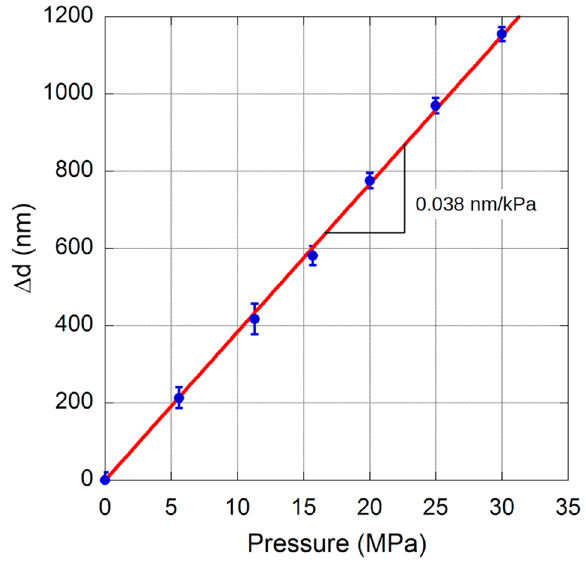
Figure 9. Diaphragm deflection as a function of pressure for a membrane 260 µm thick.